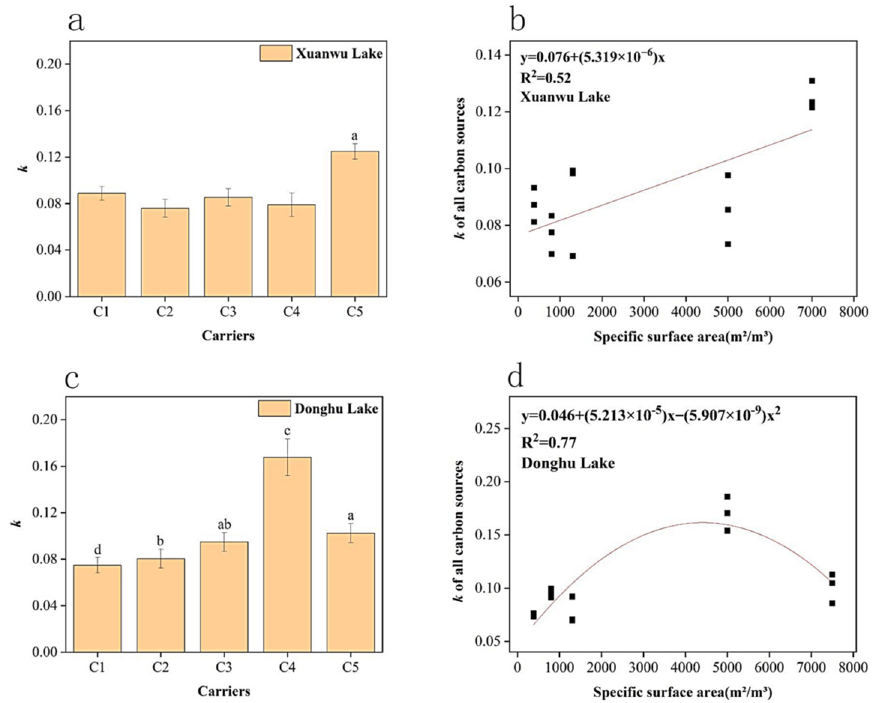
Figure 2. Comparison of carbon metabolism rate between five carriers with different specific surface areas (C1–C5) in Xuanwu Lake ( a ), and the fitting curve between carbon metabolism rate and carriers’ specific surface area in Xuanwu Lake ( b ). Comparison of carbon metabolism rate between five carriers with different specific surface areas (C1–C5) in Donghu Lake ( c ), and the fitting curve between carbon metabolism rate and carriers’ specific surface area in this lake ( d ). The letters represent a significant difference at p -value < 0.05 by using one-way ANOVA (comparison of biofilm samples from the same